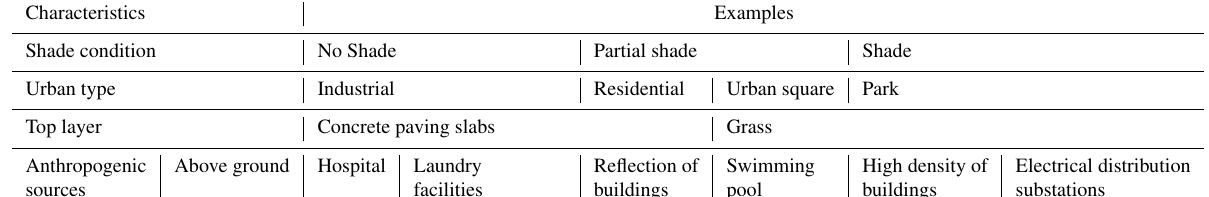
Table 3. Overview of the urban characterisation and heat sources that influence the soil temperature. Characteristics